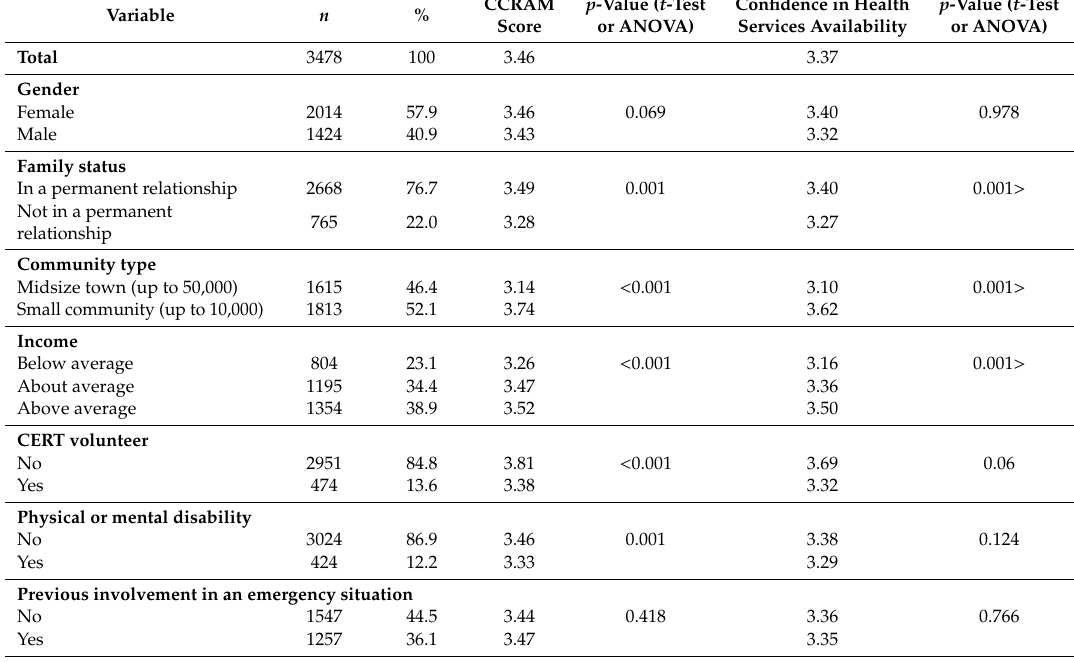
Table 1. Major study population characteristics, mean conjoint community resiliency assessment measure (CCRAM) scores and confidence in health services availability during emergency situations. p -Value ( t -Test CCRAM Variable n % Score or